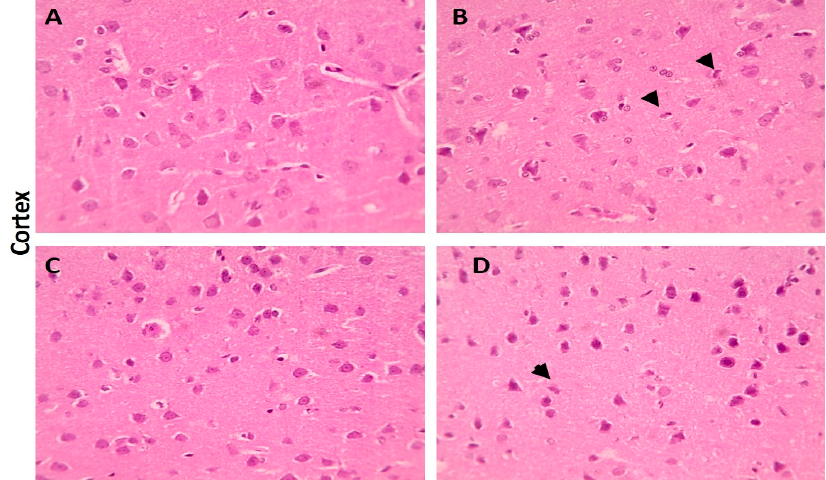
Figure 9. Histopathological examination of cerebral cortical sections using H&E. ( A , C ) Cerebral cortical section showing normal neurons, glial cells, and neuropil (H&E, 400 × ). ( B ) Cerebral cortical sectionshowing shrinkage of some neurons (black arrowheads) (H&E, 400 × ). ( D ) Cerebral cortical section showing shrinkage of a few neurons (black arrowheads) (H&E, 400 × ).